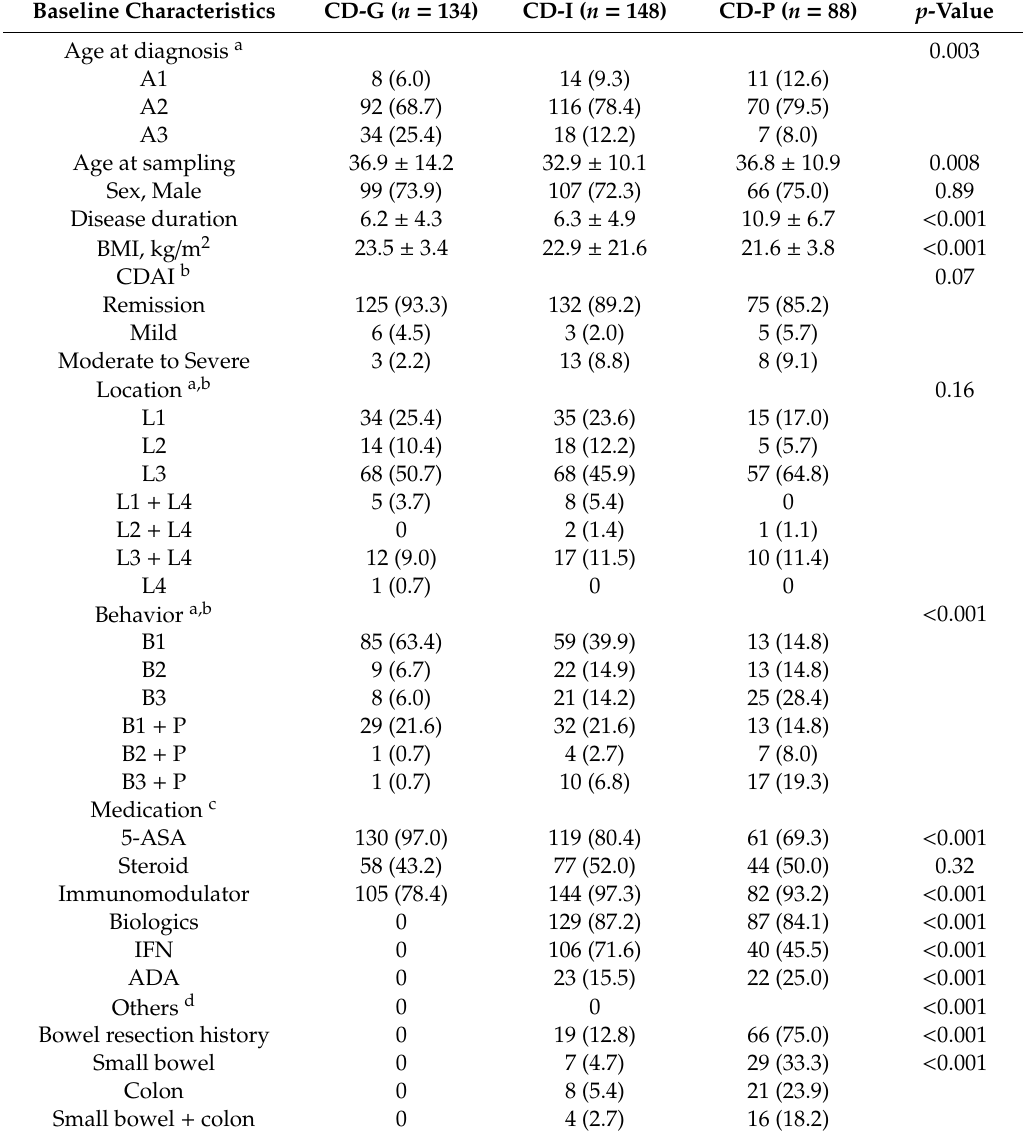
Table 1. Baseline characteristics of the patients with Crohn’s disease (CD)